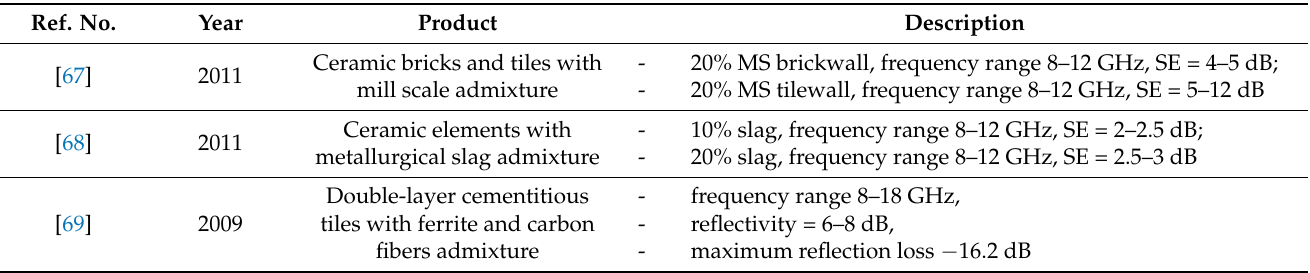
Table 5. Summary of the products described in Section 4.